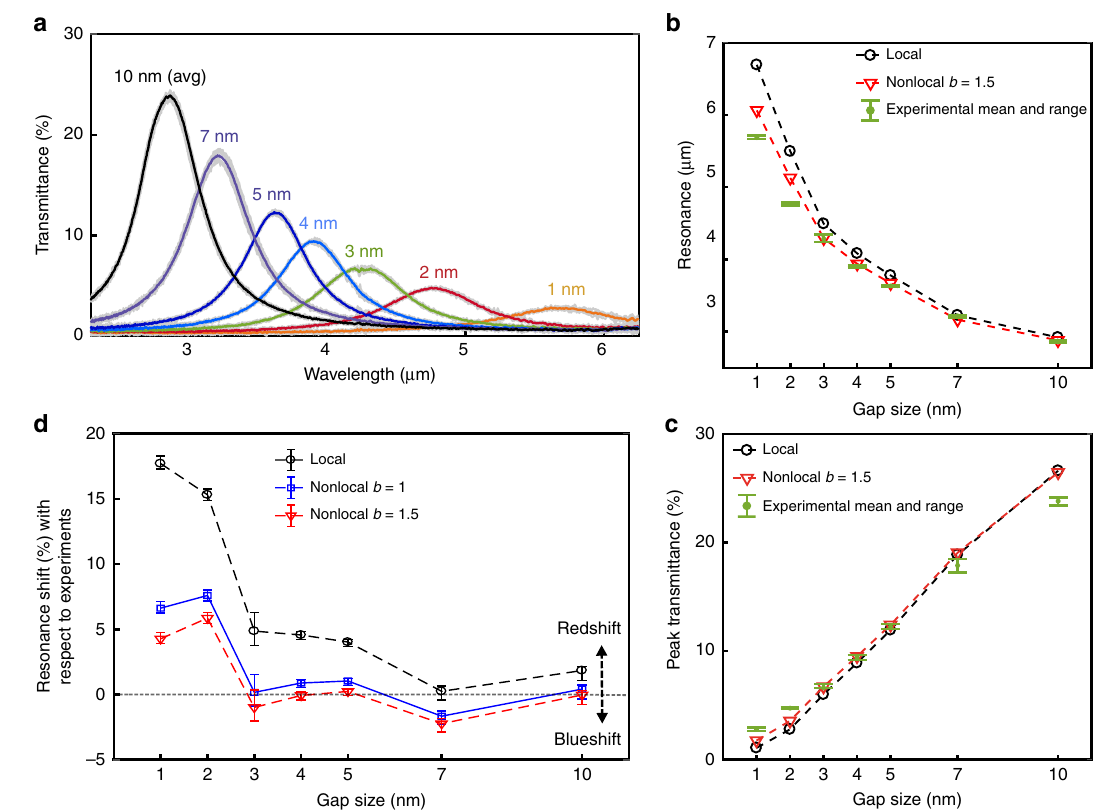
Fig. 4 Comparison of experimental data with modeling results. a Transmission spectra measured from ENZ coaxial metamaterials with different gap sizes. Gray scattering points indicate the distribution of spectra measured from eight different locations in each sample. Solid line is the average of eight measured spectra. b , c The resonance wavelengths and peak transmittance are plotted as a function of gap size for the comparison of an experiment with local and nonlocal modeling, respectively. Experimental data have an error margin calculated from the distribution of eight measured spectra. d Relative resonance shifts are calculated from ( b ) and then plotted as a function of gap